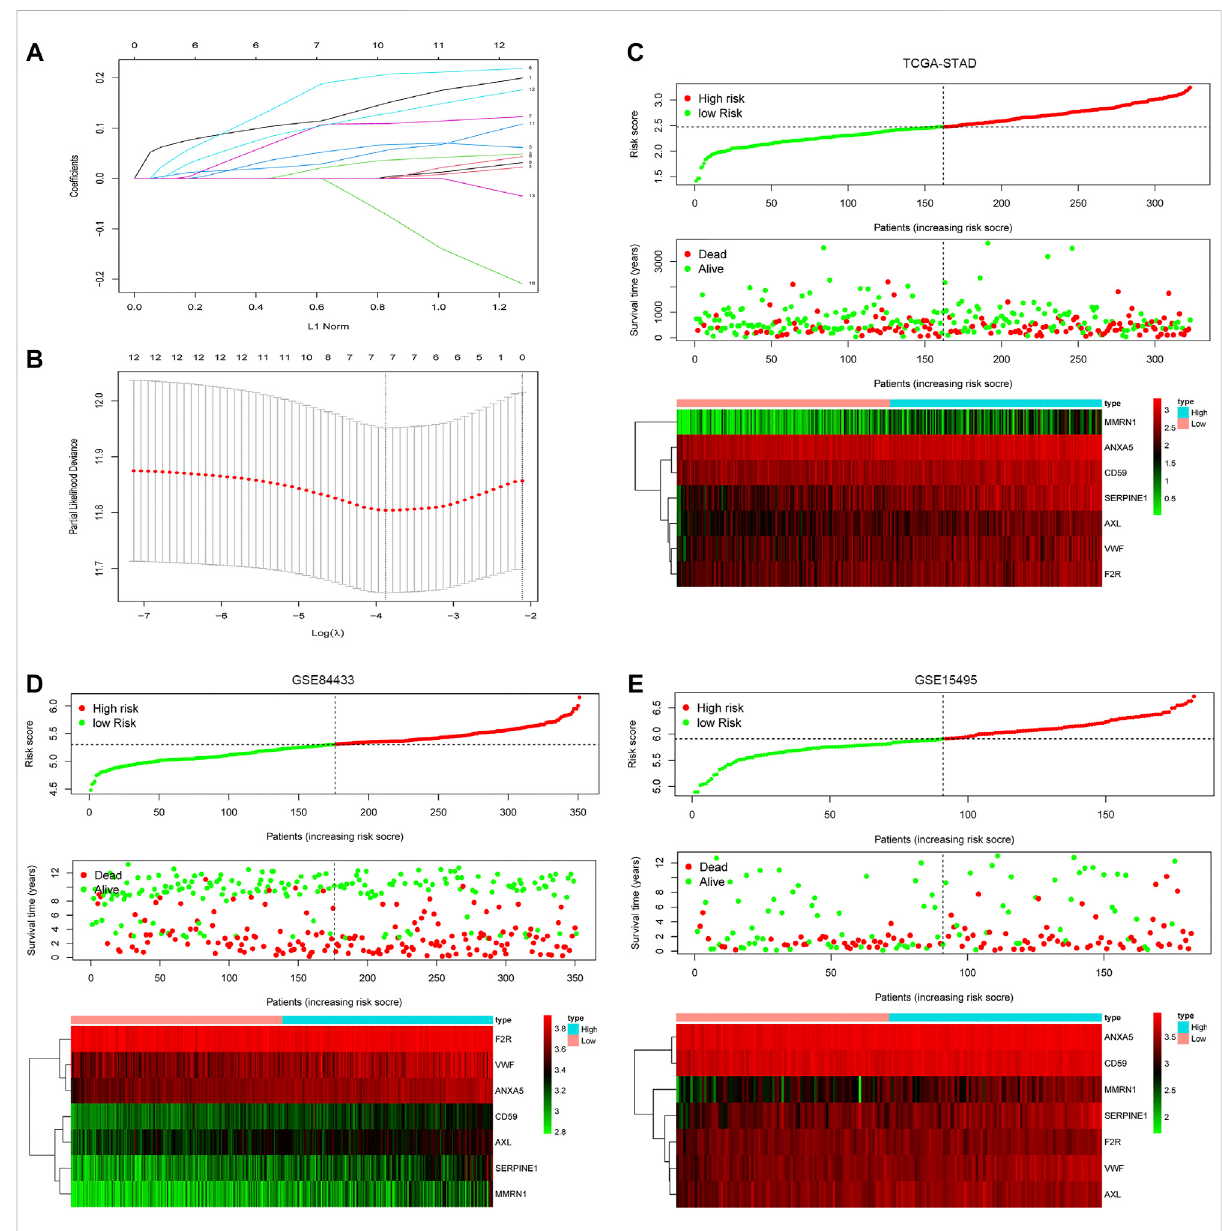
FIGURE 3 Coag-Scoremodelconstruction. (A,B) SevenCRGswerescreenedbasedonLASSOregressionanalysis. (C – E) Thedistributionsoftheriskscore for each patient (top panel), survival status of patients (middle panel), heatmaps for seven-gene signature between high-risk group and low-risk group (bottom